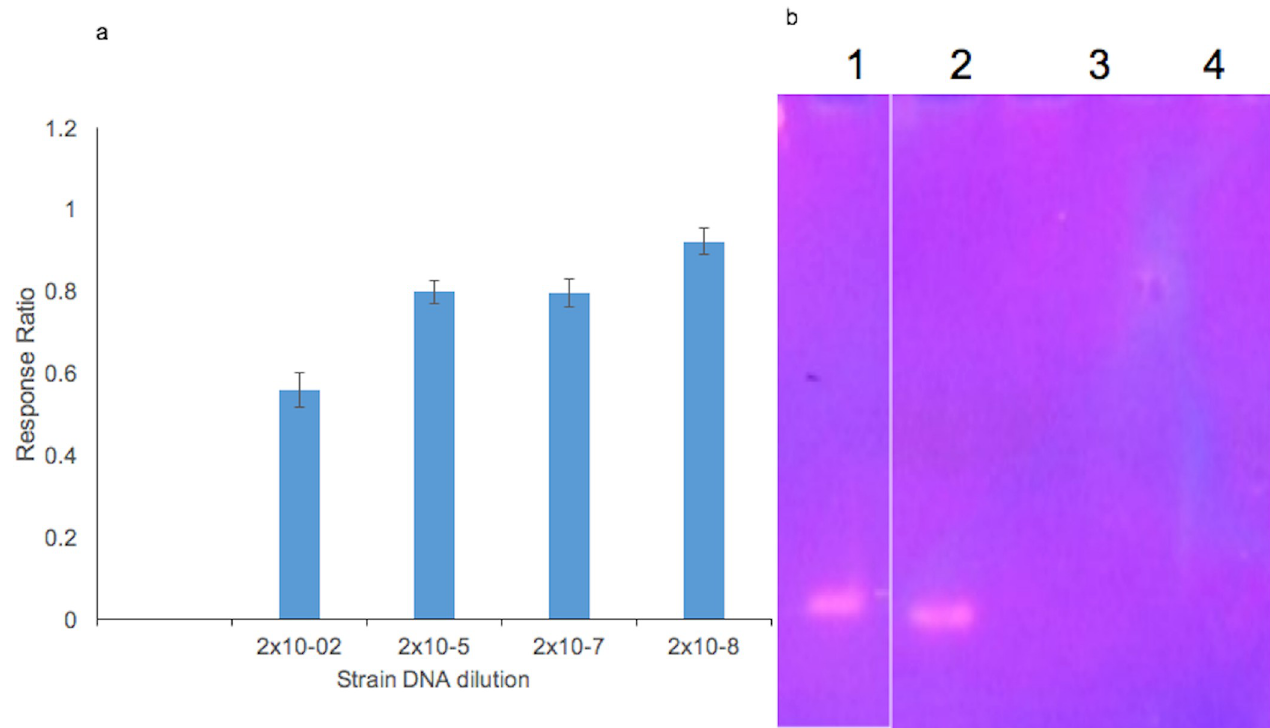
Fig 7. (A) Ratio of the sample signal (DNA) divided by the baseline signal (EA) of the concentrations, 160 ng/mL (2.00x10 -2 ), 0.016 ng/mL (2.00x10 -6 ), 0.00016 ng/mL (2.00x10 -8 ) and 0. 0.000016 ng/mL (2.00x10 -9 ). (B) 12% acrylamide gel of the PCR amplicons at dilutions 1 (2.00x10 -2 ), 2 (2.00x10 -6 ), 3 (2.00x10 -8 ) and 4 (2.00x10 -9 ).